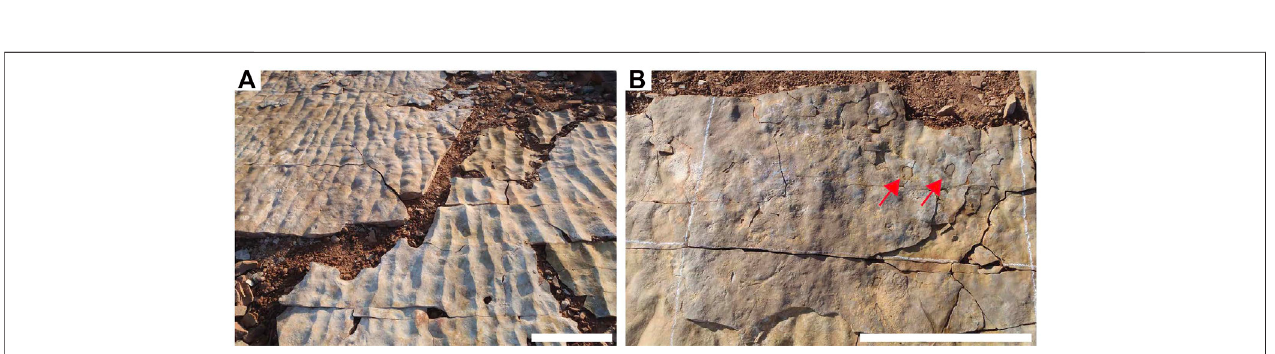
FIGURE4| ImagesofbedSTC-Gand STC-GShim. (A) Excavated and fl ippedsolesurfaceofSTC-G(left)andtopbeddingsurfaceofshimunderlyingSTC-G. (B) Image of the sole surface of STC-G with STC-G Shim still in place, red arrows denote macrofossils from the underlying bed that were not cast by STC-G Shim but were cast by the thicker STC-G. Scale bars = 50 cm. (A) Modi fi ed from Tarhan et al. (2017).